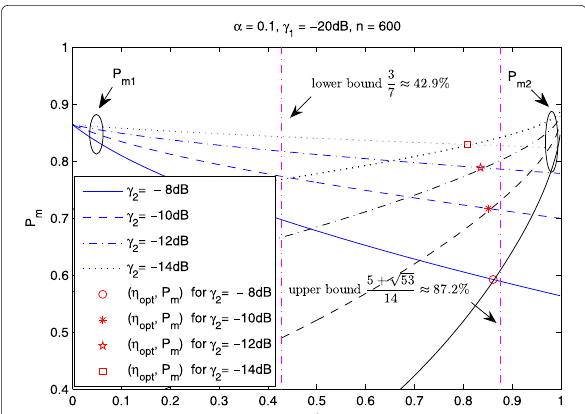
Fig. 3 Missed detection probabilities of SU 1 and SU 2 versus relay policy under different SNRs of SU